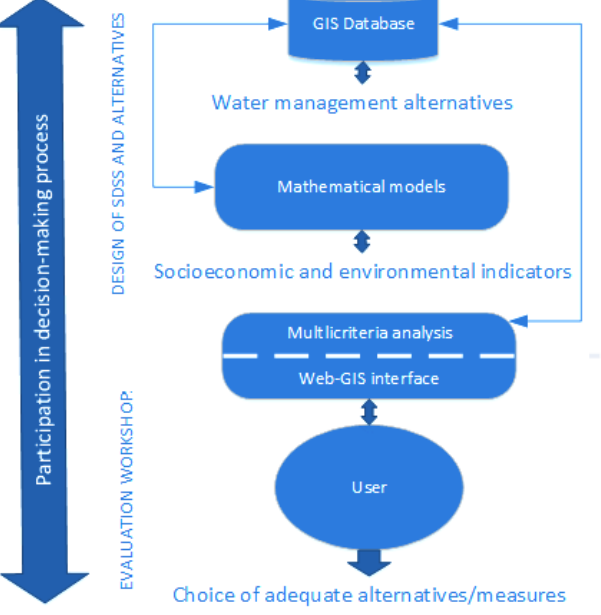
Fig. 2. Architecture of the spatial decision support system (SDSS), with (1) a spatial database manager, (2) a scenario and alternatives generator, and (3) a user interface embedded in a web 2.0